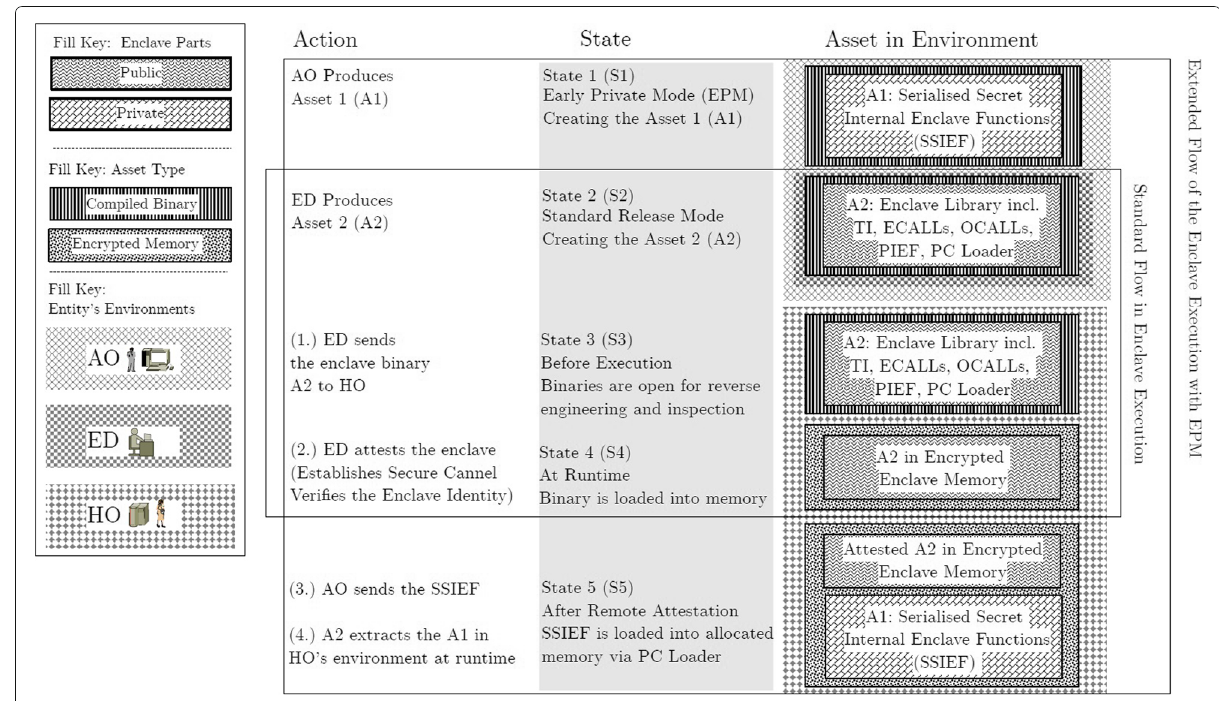
Fig. 8 The StandardExecution of an enclave, and the ExtendedExecution flow with EPM for private algorithms. The difference is that the AO takes also a role in development of the enclave for private parts. The Asset 1 containing the private algorithms is loaded late in the HO ’s environment for secret-code execution after verifying the attestation report